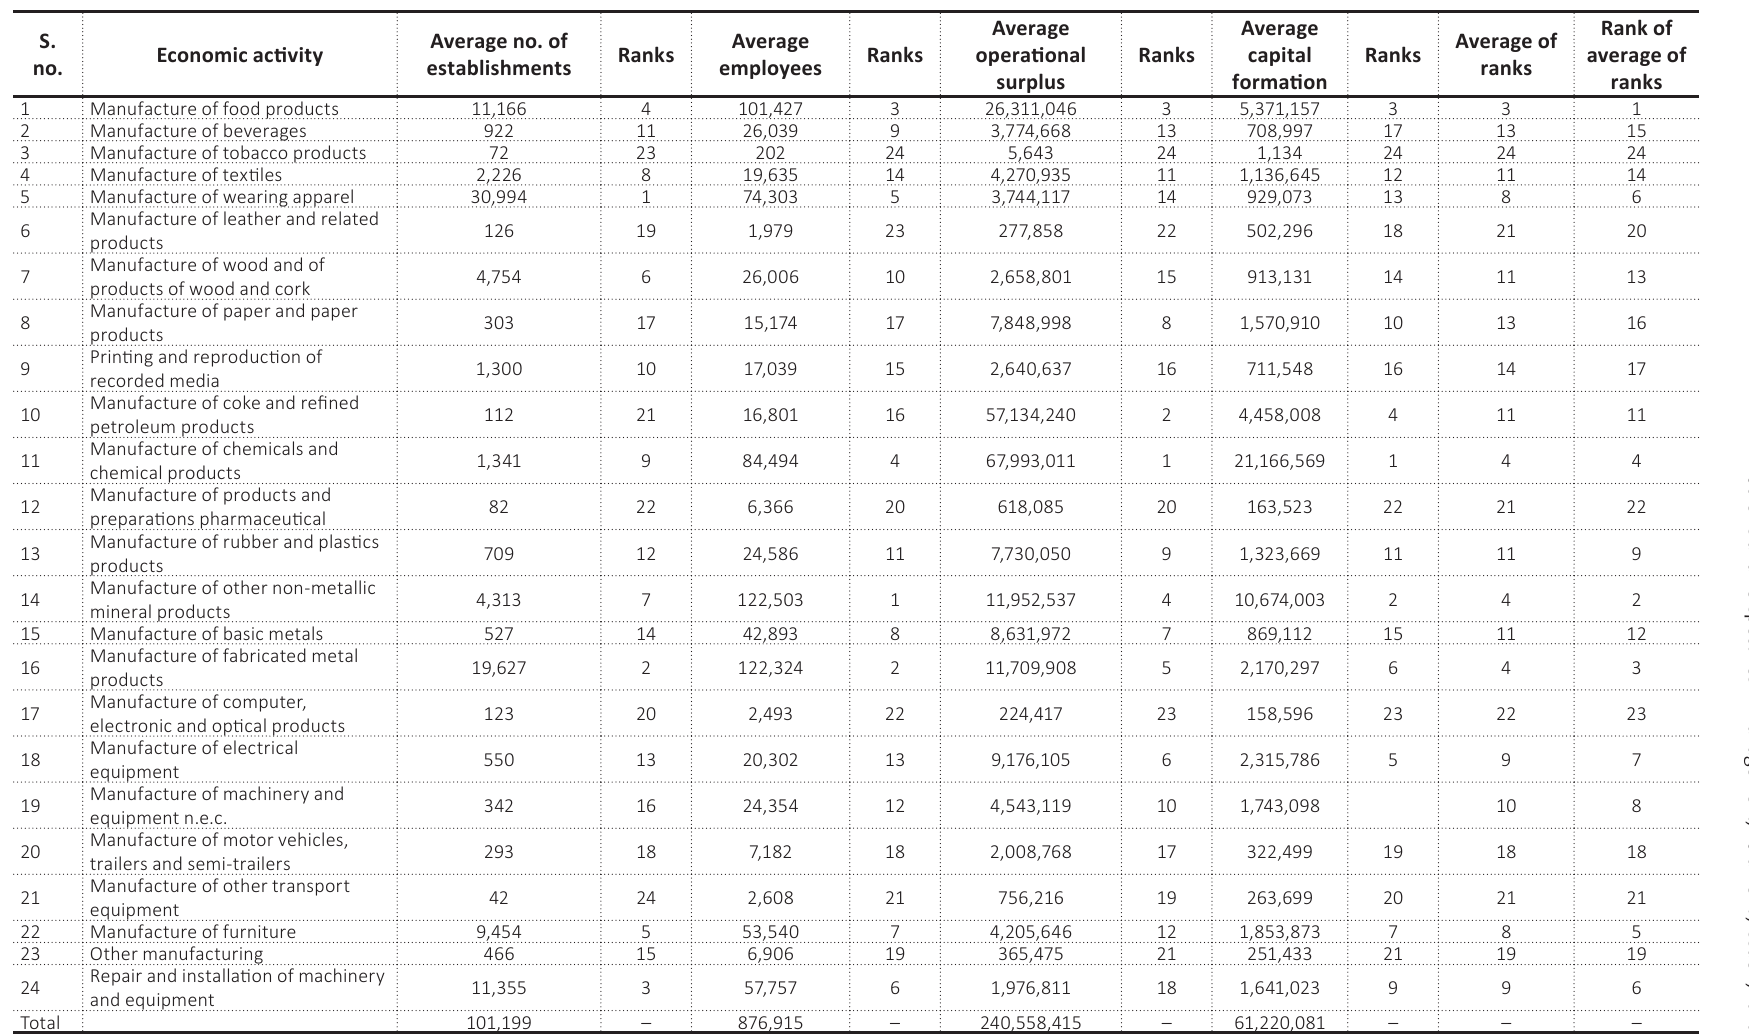
Table C1. Growth and development of manufacturing industries in Saudi Arabia